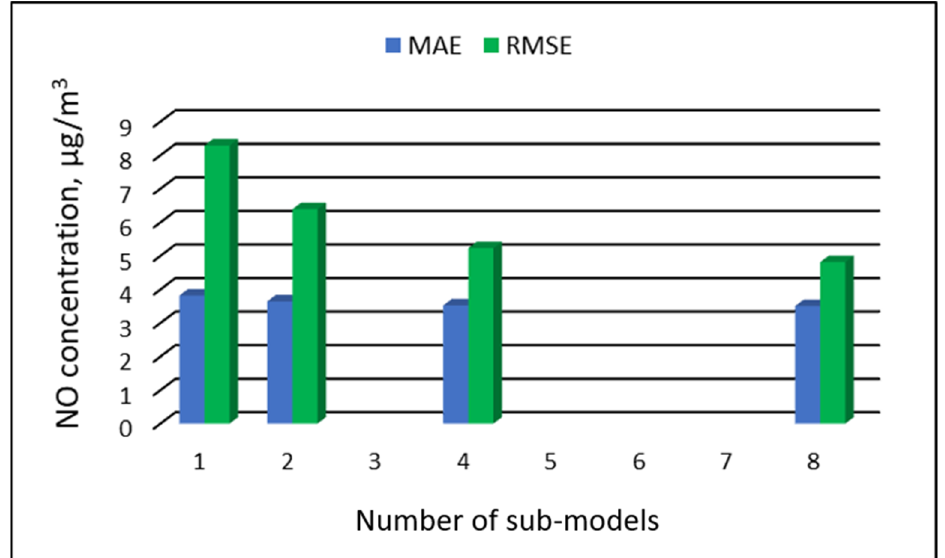
Table 8. Values of approximation errors of NO concentrations in PVS models, Z ł oty Potok 2011– 2016.